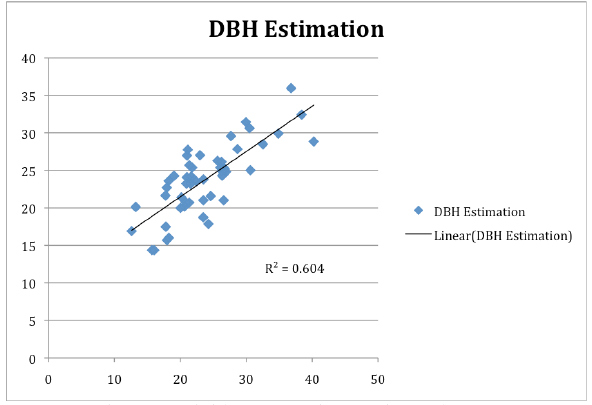
Figure 8: Field DBH against Estimated